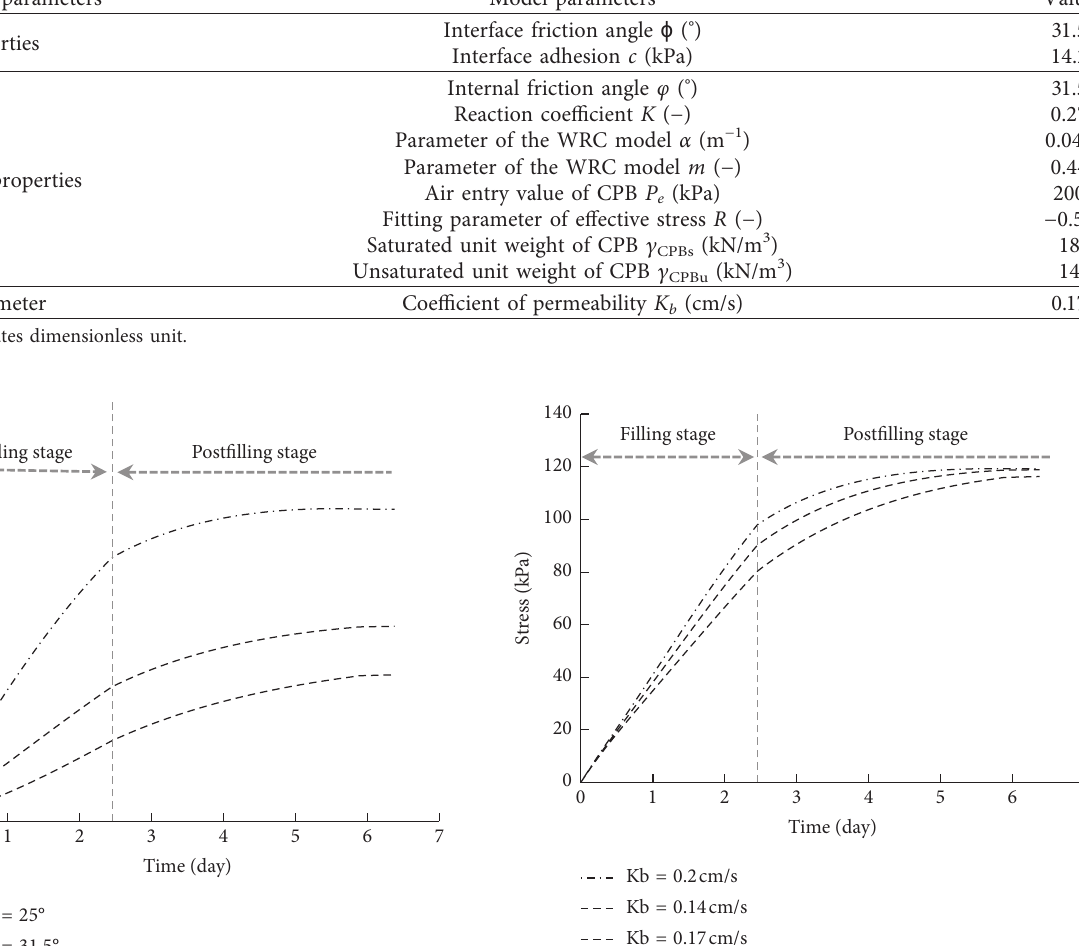
Table 7: Model parameters adopted for sensitivity analysis and model application.